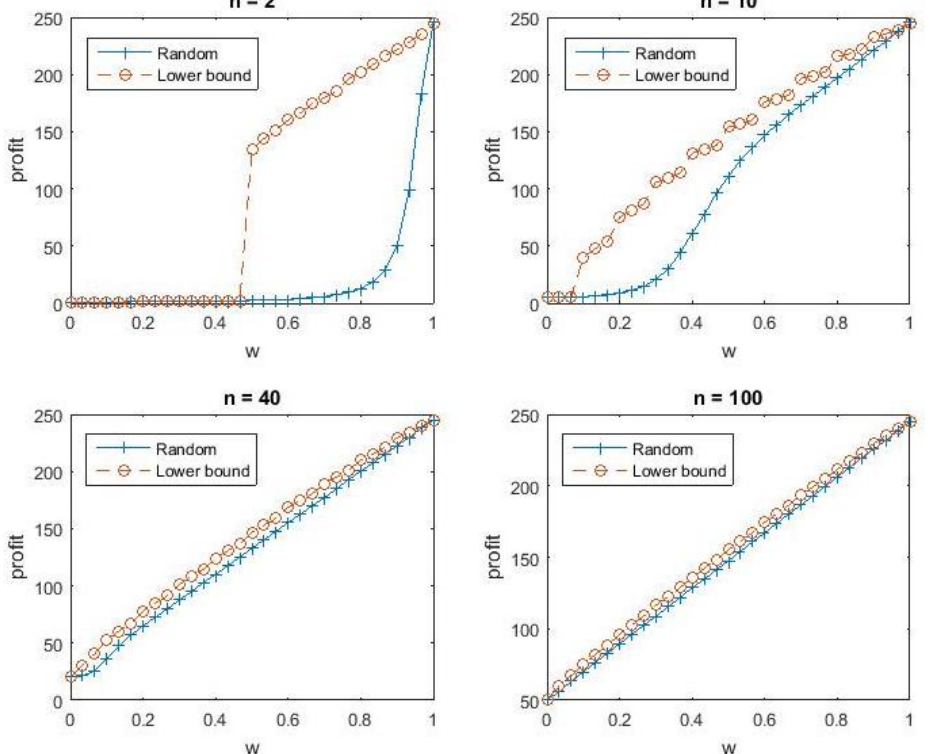
Figure 1. Criminal’s profit as a function of w for four different values of n when c = 0.01 and δ =